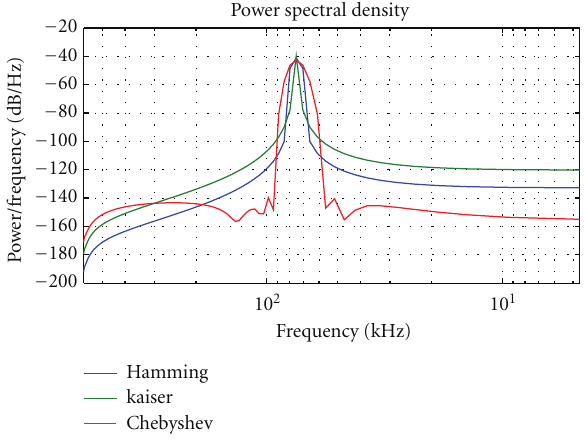
Figure 4: Power spectral density of FM modulator.